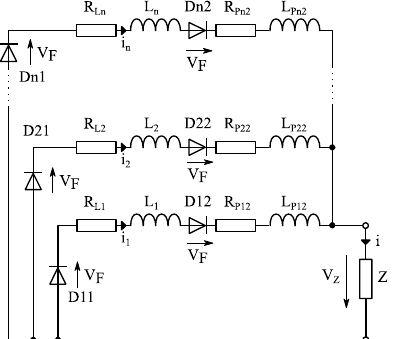
Figure 4. Substitute scheme for the second working period of the